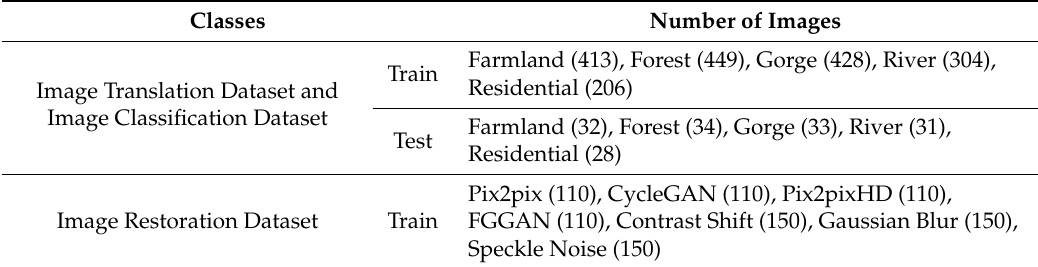
Table 1. The information of images involved in the Image Translation, Image Restoration, and Image ClassificationDatasets.Valuesintheparenthesesrepresentthespecificnumberofimagesineachcategory.